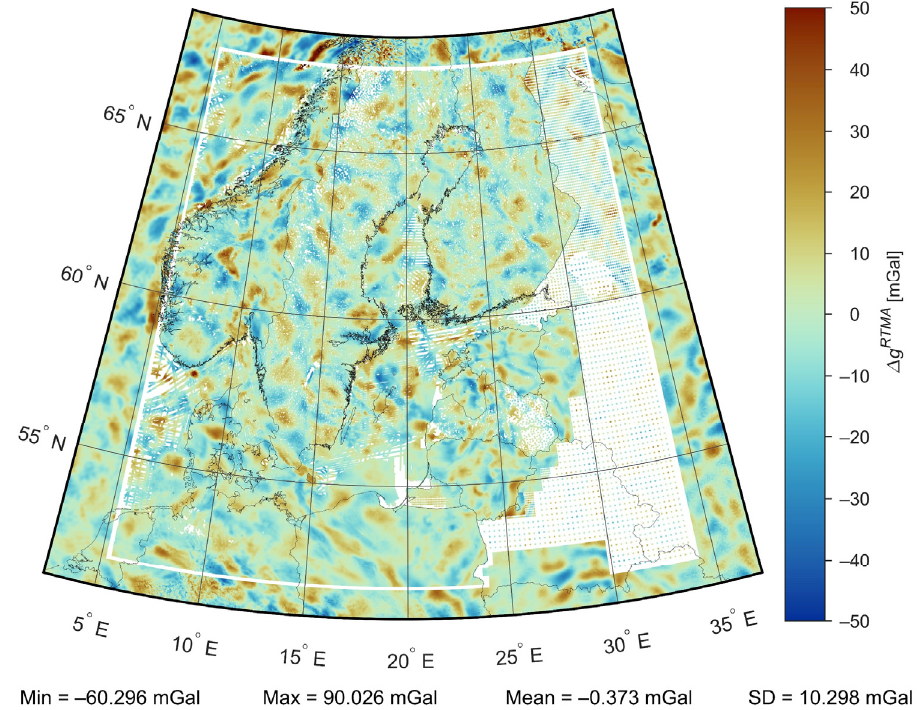
Figure 8. RTM anomalies computed by also considering bathymetry information.